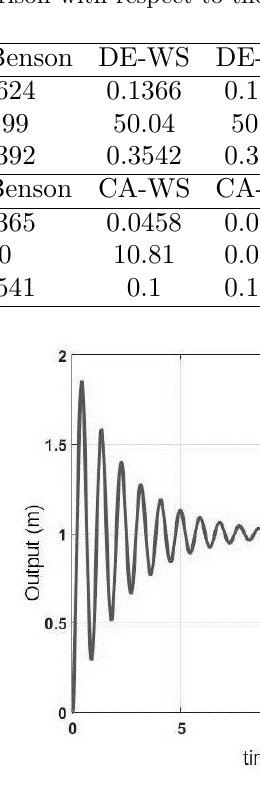
Table 1. Time response parameter comparison with respect to the step input.